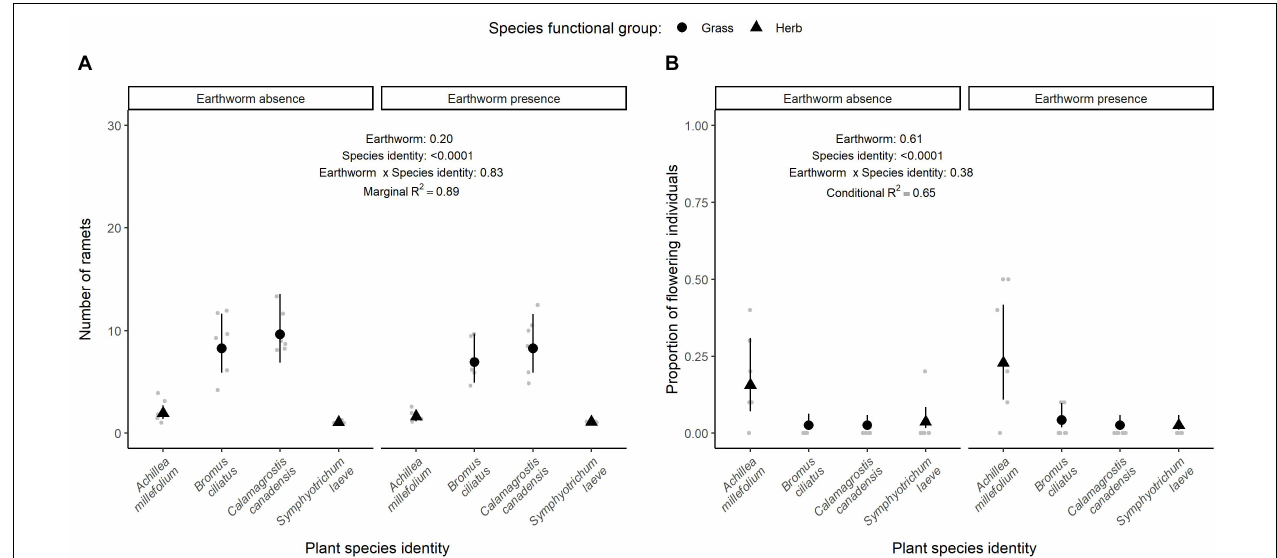
FIGURE 4 | Effect of earthworm presence on reproductive traits: number of ramets (A) and proportion of flowering individuals (B) . Estimated marginal means and confidence intervals are shown in black (after being back-transformed), while data points were included in the background in gray. The conditional R 2 or marginal R 2 in the case of the number of ramets as well as the p -values for each factor are based on linear mixed effect models. Number of observations per species and treatment: 6, except for the proportion of flowering individuals of B. ciliatus in the control treatment, where there are five